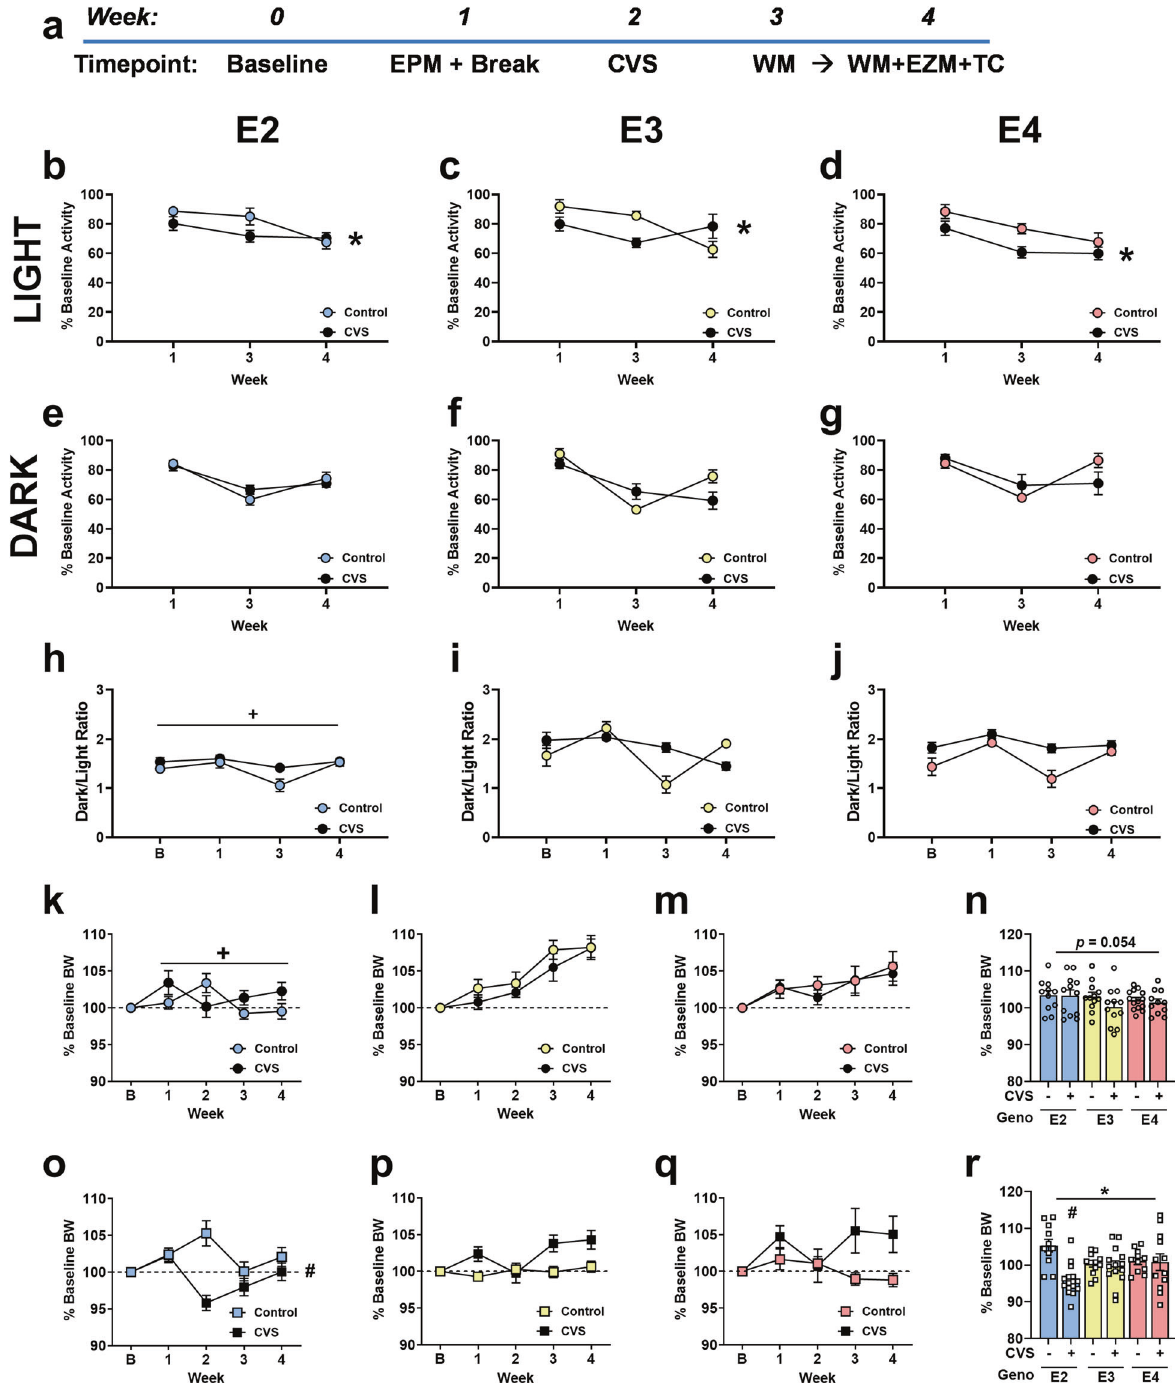
Fig. 1 Experimental design and home cage activity. a Experimental design, body weights, and home cage activity. EPM = Elevated Plus Maze. CVS = Chronic Variable Stress. WM = Water Maze. EZM = Elevated Zero Maze. TC = Tissue Collection. b – d Percent baseline home cage activity during the light cycle throughout the experiment shows that CVS exposure resulted in overall less activity compared to controls (* p < 0.05). e – g Percent baseline home cage activity during the dark cycle was not altered by genotype or CVS exposure. h – j Activity was also assessed a ratio of activity during the light and dark cycles, which showed E2 mice overall had lower dark/light ratios ( + p < 0.05). B = Baseline. Sexes were collapsed for panels b – j . k – m Female mice overall gained body weight throughout the experiment; however, this growth was not seen in either female E2 group ( + p < 0.05). o – q In males, percent baseline bodyweights changed throughout the weeks of testing. These within-subject changes over the weeks were in fl uenced by genotype and CVS exposure, as well as by an interaction between genotype and CVS exposure (# p < 0.05). Percent baseline bodyweight during week 2, the week of CVS exposure, was assessed separately to better understand these interactions. While females exposed to CVS showed a trend to lower percent baseline bodyweights ( p = 0.054) ( n ), CVS exposed males showed lower percent baseline bodyweights compared to controls (* p < 0.05) which was due to the lower percent baseline bodyweight in E2 CVS males compared to E2 control males ( r ) genotype x group interaction: # p < 0.05. Symbols: + refers to pairwise comparison of genotype effect, * refers to CVS effect, # refers to genotype x CVS interaction. Translational Psychiatry (2022)